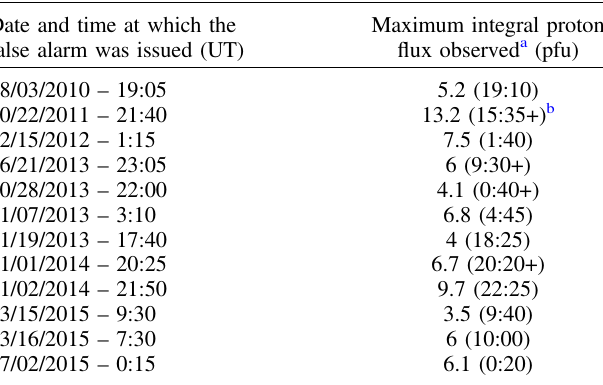
that is, we tested two combined tools (see the last two columns of Table 10): UMASEP-10sxr94, which uses the WCP-euv94,